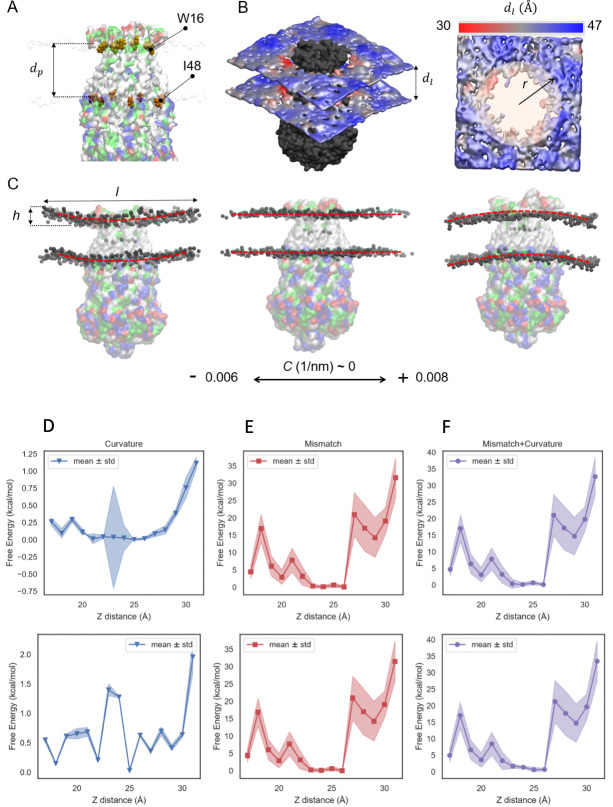
Geometrical properties of MscS embedded in a lipid bilayer for PMF calculations.(A) Surface representation of MscS with residue-type color map. Red color shows negatively charged residues, blue shows positively charged residues, green hydrophilic and grey hydrophobic residues of MscS while embedded in the bilayer. A van der Waals illustration of residues W16 and I48 at the lipid-protein interface has been shown for determining the hydrophobic length of the protein, dp. (B) An example membrane thickness (dl) distribution (from the simulation with Z distance = 31 Å) shown in color spectrum ranging from ~ 30 Å (around the protein) to ~ 47 Å (near the edges). (C) Snapshots of the membrane with different curvatures (C), which are calculated based on the length (l) and the height (h) of the bilayer. (D–F) The mean-field free energy change due to change in the bilayer curvature and lipid-protein hydrophobic mismatch as a result of different MscS position with respect to the membrane. Top panel indicates the free energy change assuming constant curvature across the bilayer area and the bottom panel assume variable curvature across the bilayer area. (D) Indicates the free energy contribution of curvature change at different umbrella sampling windows, (E) shows the contribution of the free energy change due to hydrophobic mismatch between MscS and the bilayer, and (F) shows the combination of the free energy from both curvature and hydrophobic mismatch. Hydrophobic mismatch is the main contributing factor in change in the free energy level across different reaction coordinates. The values are mean ± std.